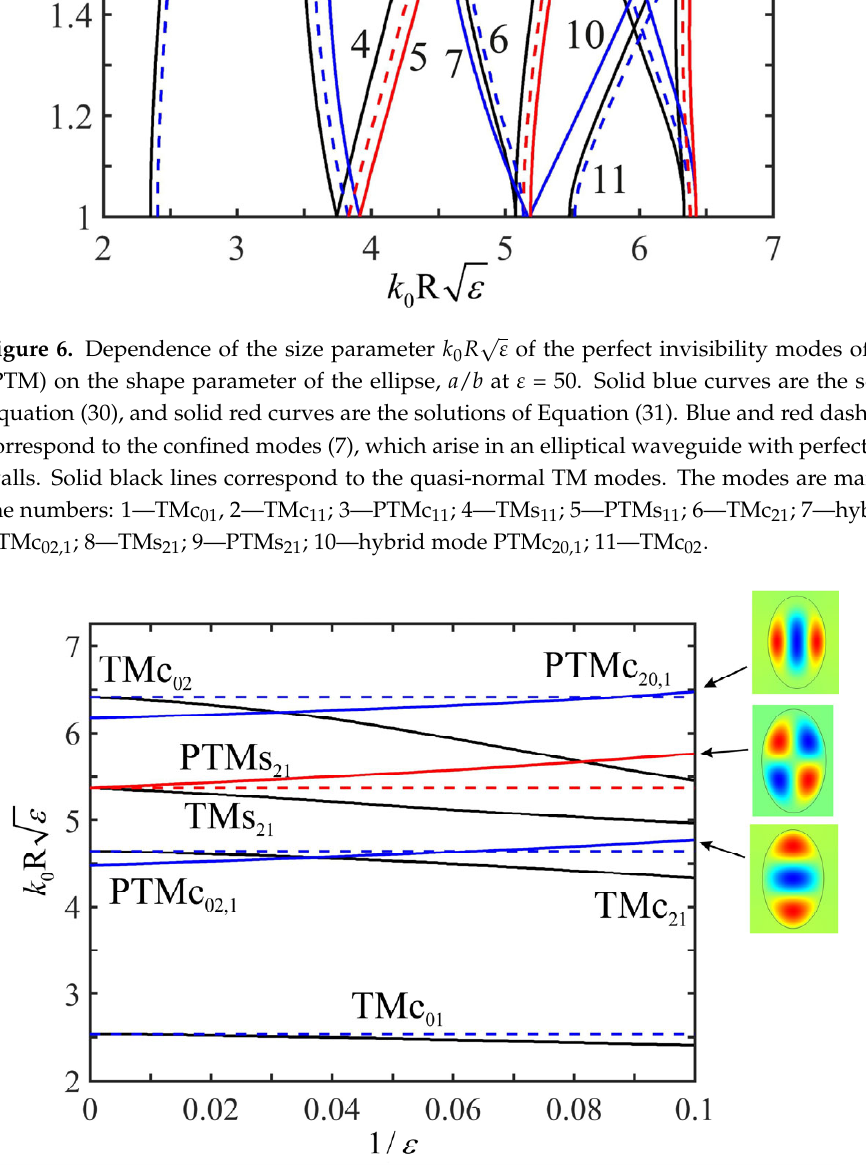
Figure 8. Eigenfrequencies